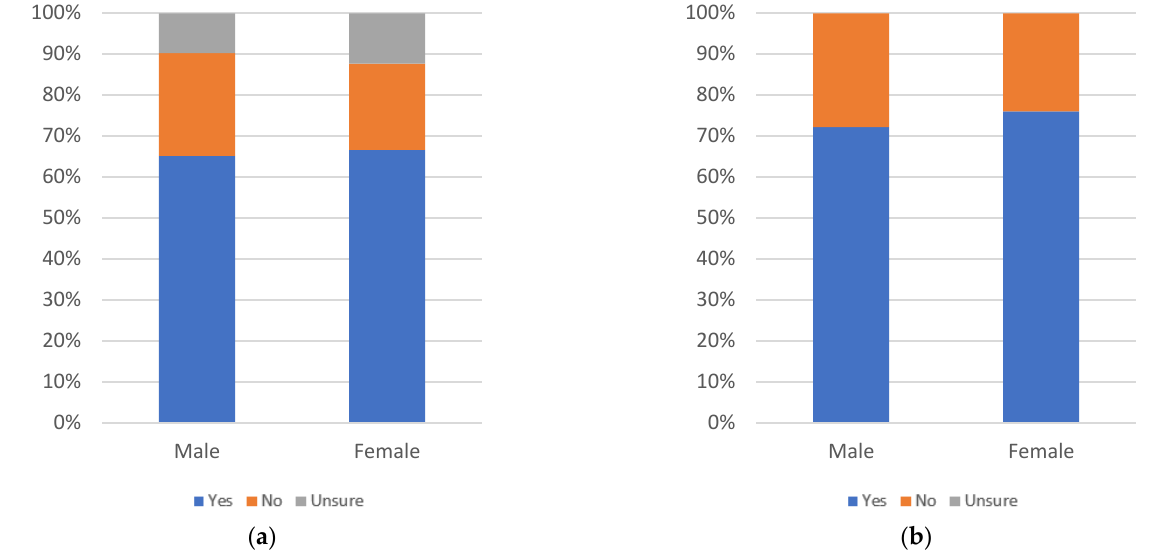
Figure 71. Label helpfulness, by gender: ( a ) with uncertain respondents (left) and ( b ) without uncertain respondents (right).